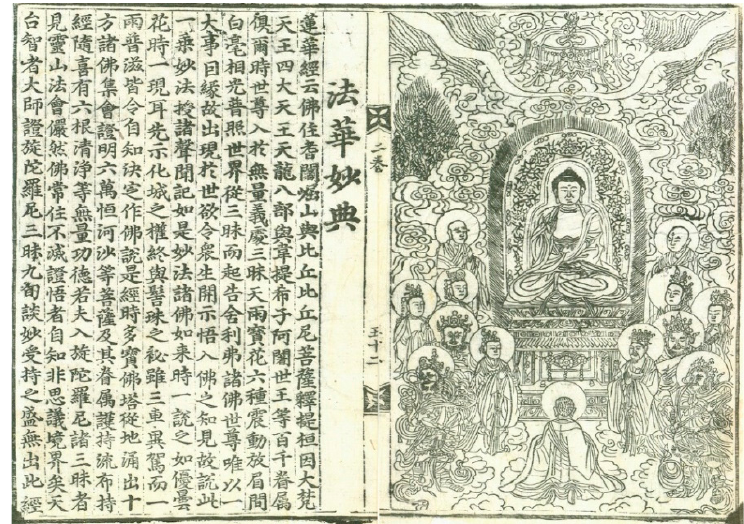
Figure 14. Seokssi wollyu , “Beophwa myojeon 法華妙典 ” Vol. 2, published at Buramsa Temple, Joseon (1673), private collection. Photo by the author.